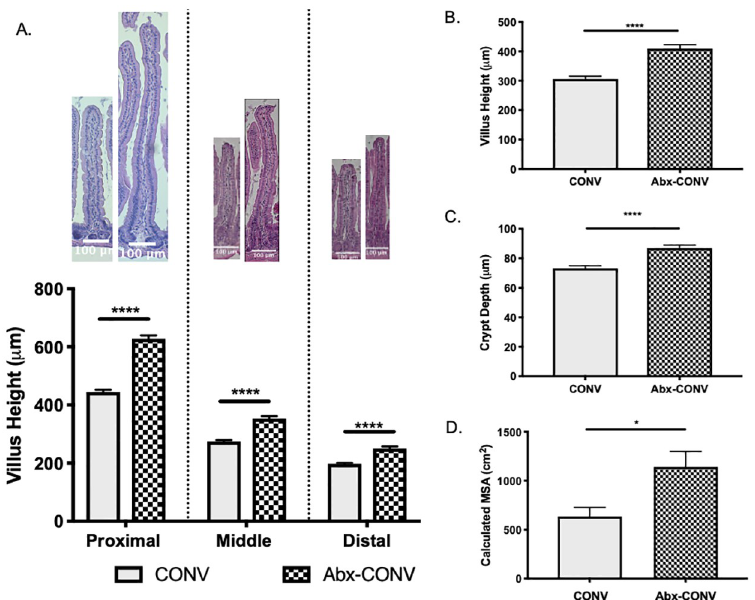
Fig 3. Morphometric parameters in CONV mice after 28 days of treatment. (A) Abx-CONV mice demonstrate considerably taller villi in the proximal, middle, and distal small intestine compared to vehicle as depicted histologically and graphically. (B) Mean villus height, (C) mean crypt depth, and (D) mean calculated mucosal surface area for all small intestinal regions are also significantly greater in the Abx-CONV mice. Values presented as Mean ± SEM; � p < 0.05, ���� p < 0.0001; n = 4 CONV mice, n = 5 Abx-CONV mice.